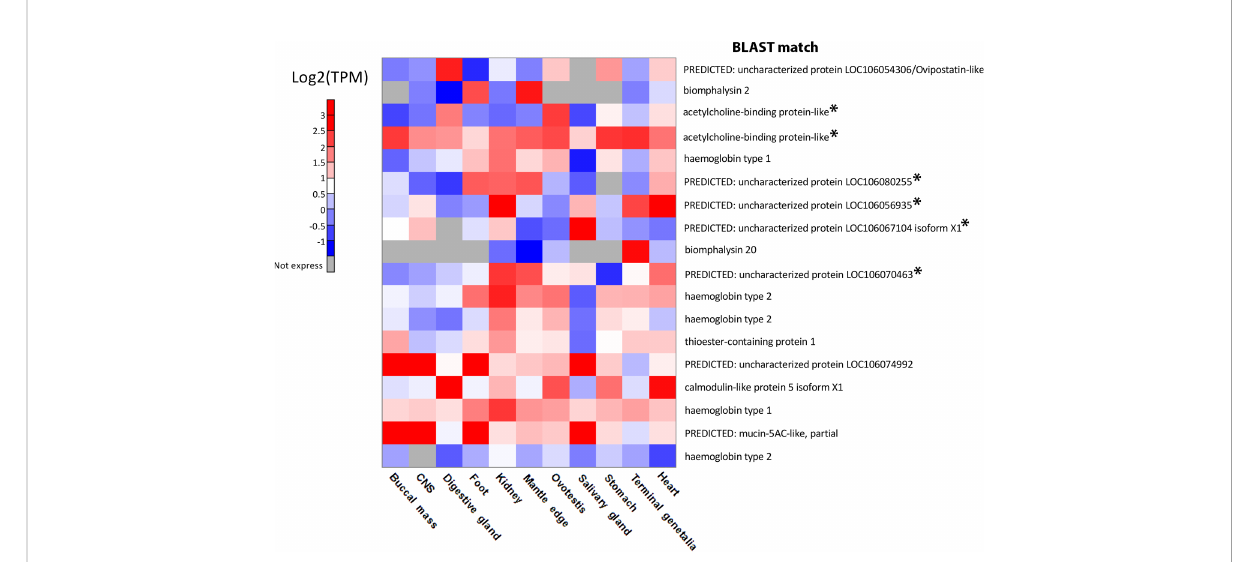
FIGURE 5 A heatmap displaying the log 2 gene expression levels of attractant candidates in B glabrata tissues. Colour: Red: High expression; Blue: Low expression; Grey: No expression. Attractant candidates have been denoted with an